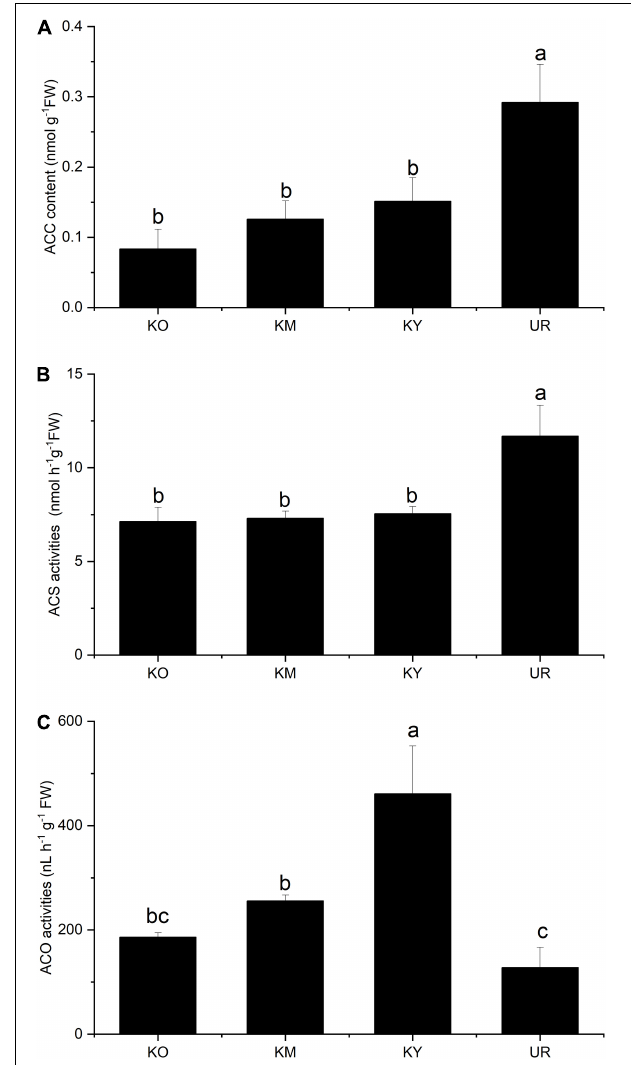
FIGURE 5 | ACC content (A) and ACS (B) and ACO (C) activities in different roots of Taxodium ascendens. KO, KM, and KY refer to the knee roots at different development stages: old-aged stage, middle-aged stage, and young-aged stage, respectively. UR means underground roots. ACS, 1-Aminocyclopropane-1-carboxylic acid synthetase; ACO, 1-Aminocyclopropane-1-carboxylic acid oxidase. Values followed by the same letter(s) are not significantly different at P < 0.05, according to Duncan’s multiple range tests. Error bars are SD of the mean; n =